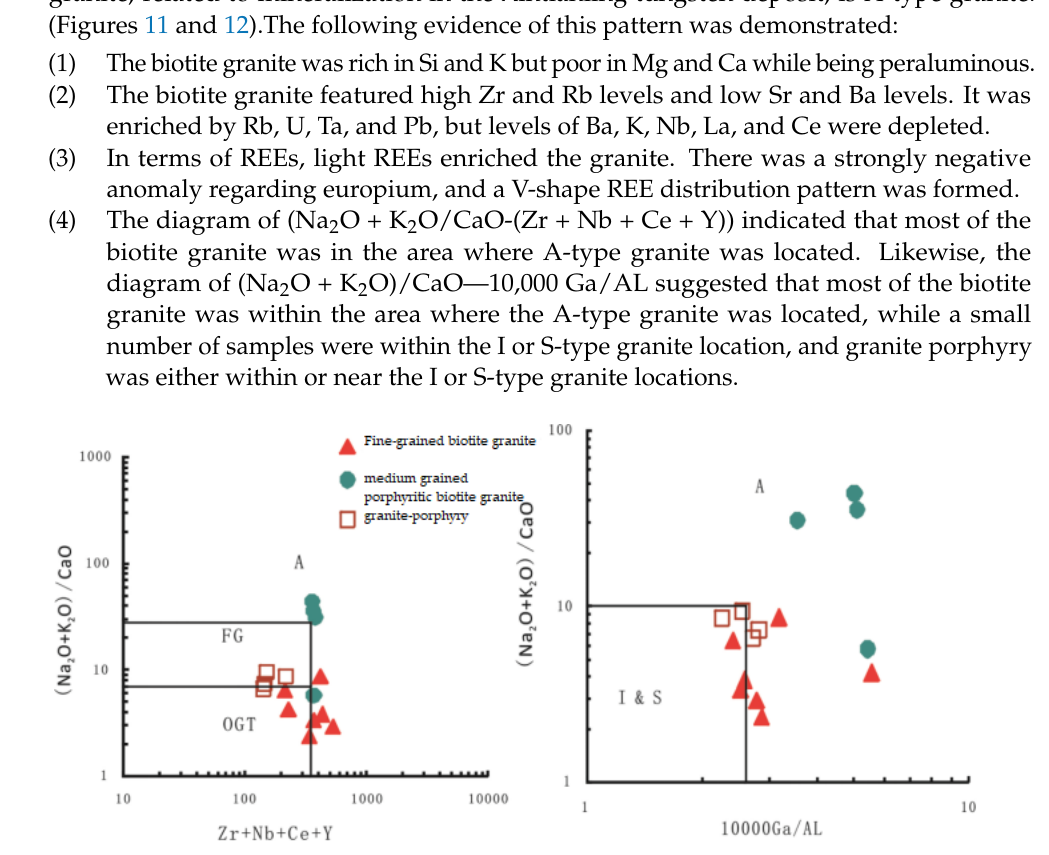
Figure 11. Plots of (Na 2 O + K 2 O)/CaO versus (Zr + Nb + Ce + Y) and (Na 2 O + K 2 O)/CaO versus 10,000 Ga/AL of the Xintianling granite. The areas indicated in the above diagrams are from J.B. Whalen